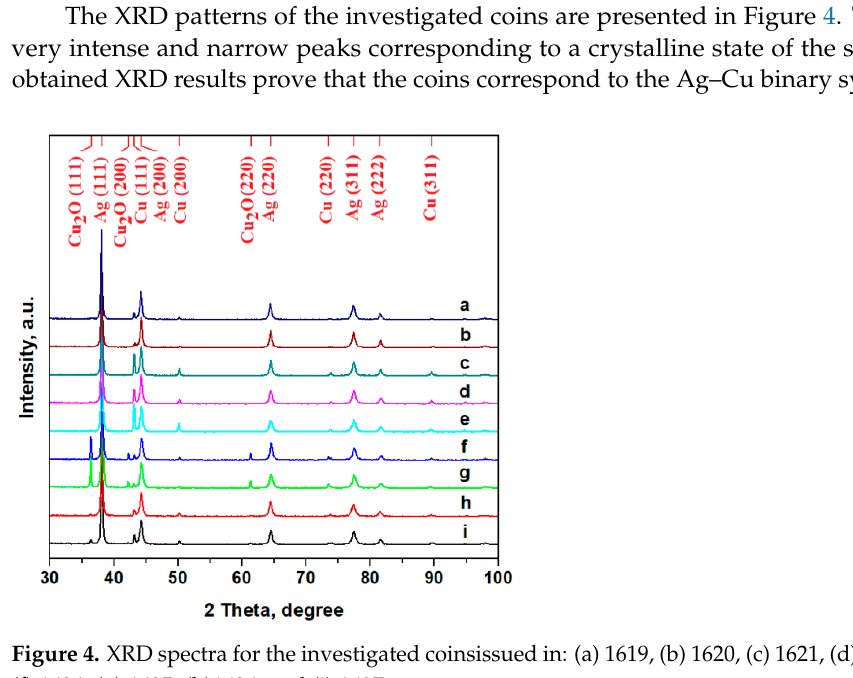
Figure 3. Metallographic microstructures of 3-Polker coin issued in 1619: ( a ) general view and ( b ) microstructure detail and of coin issued in 1625: ( c ) general view and ( d ) microstructure detail, where: E—eutectic, α —silver phase, and β —copper phase.